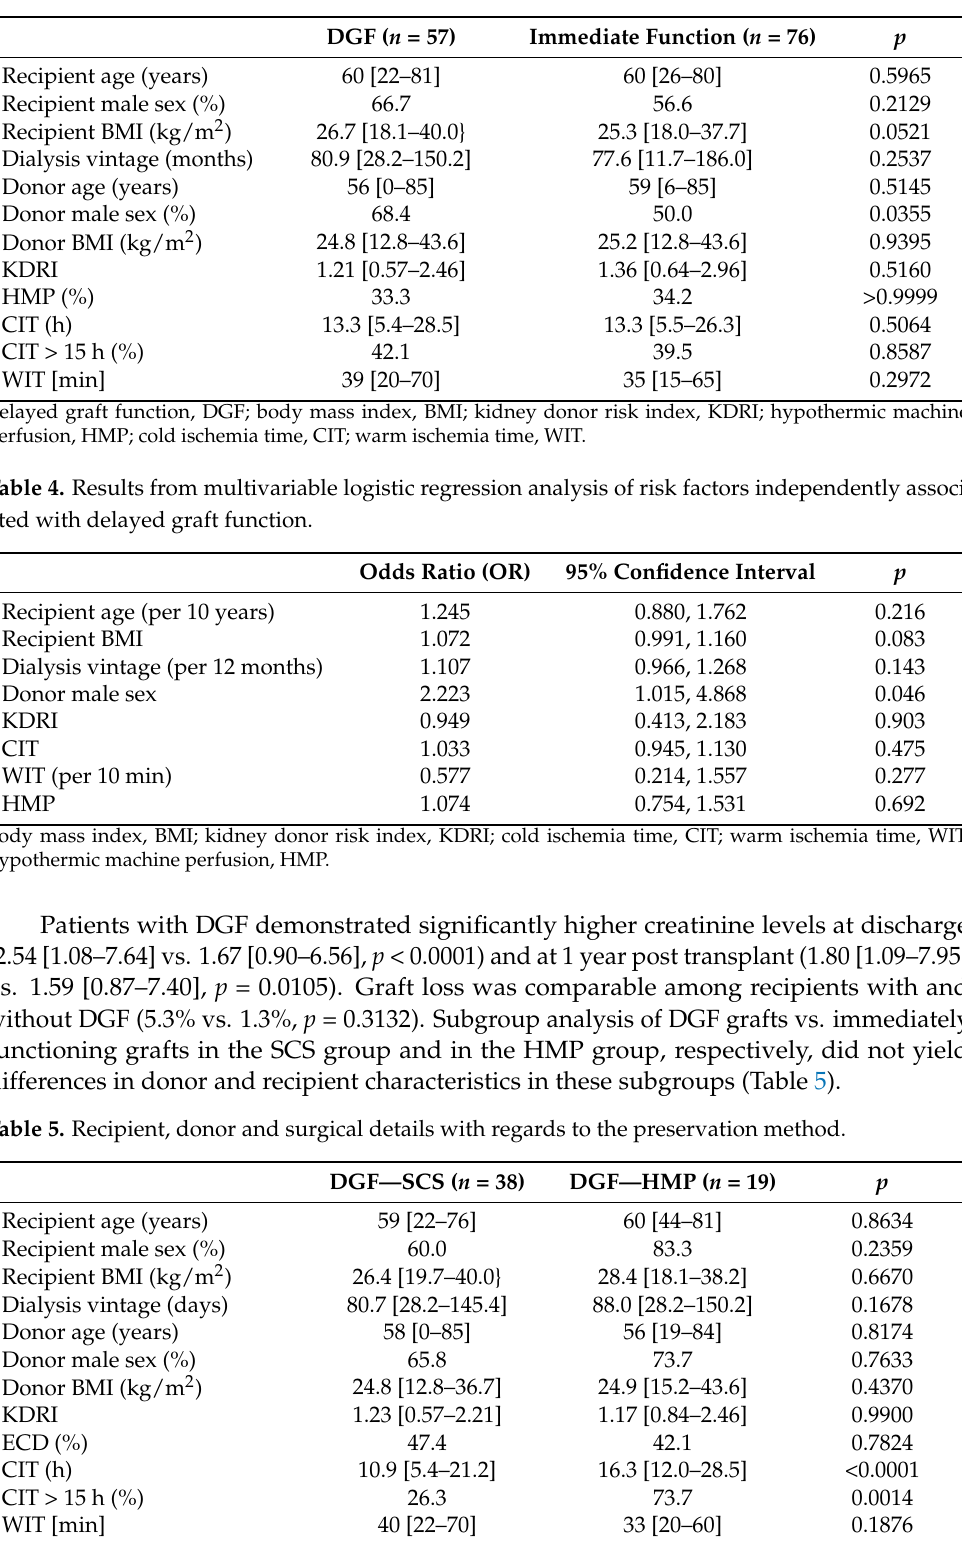
Table 3. Recipient, donor and surgical details with regards to initial graft function.